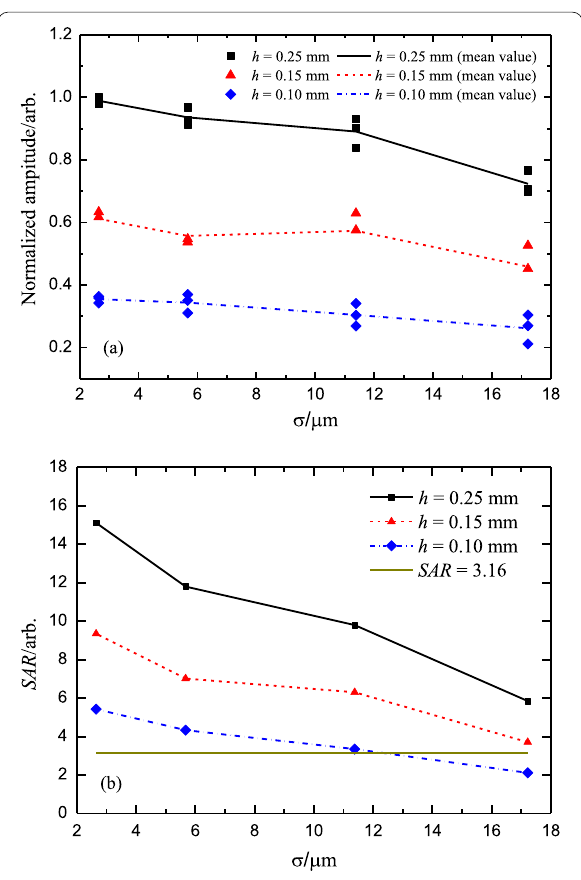
Figure 12 a Normalized amplitudes and mean values and b SAR values of micro-cracks under rough front surfaces